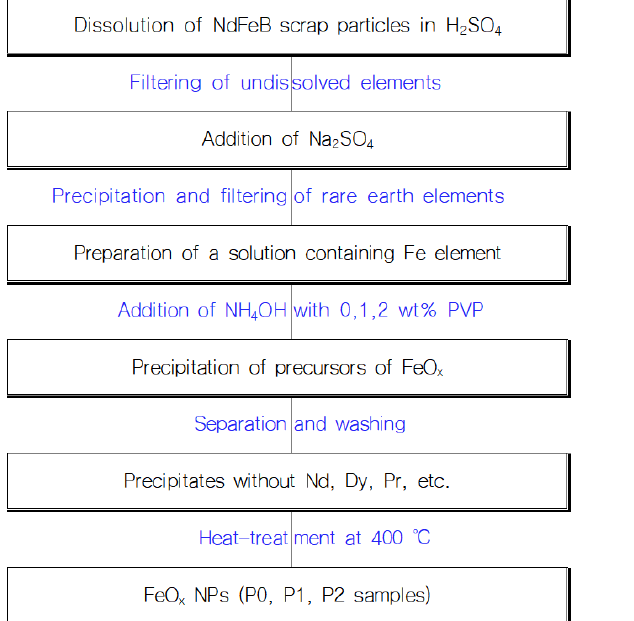
Figure 1. Schematic representation of the procedure and mechanism for the formation of FeO x NPs.